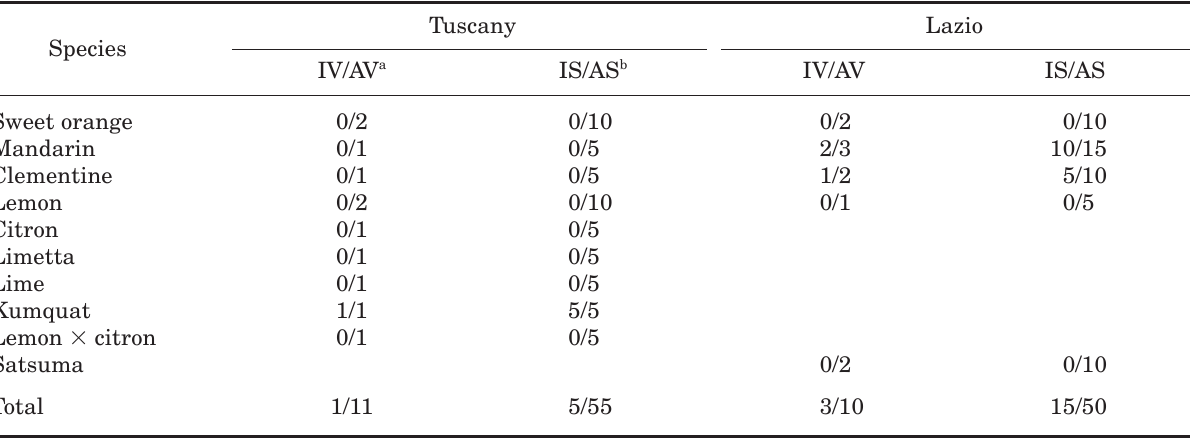
Table 3. Distribution of HSVd in Tuscany and